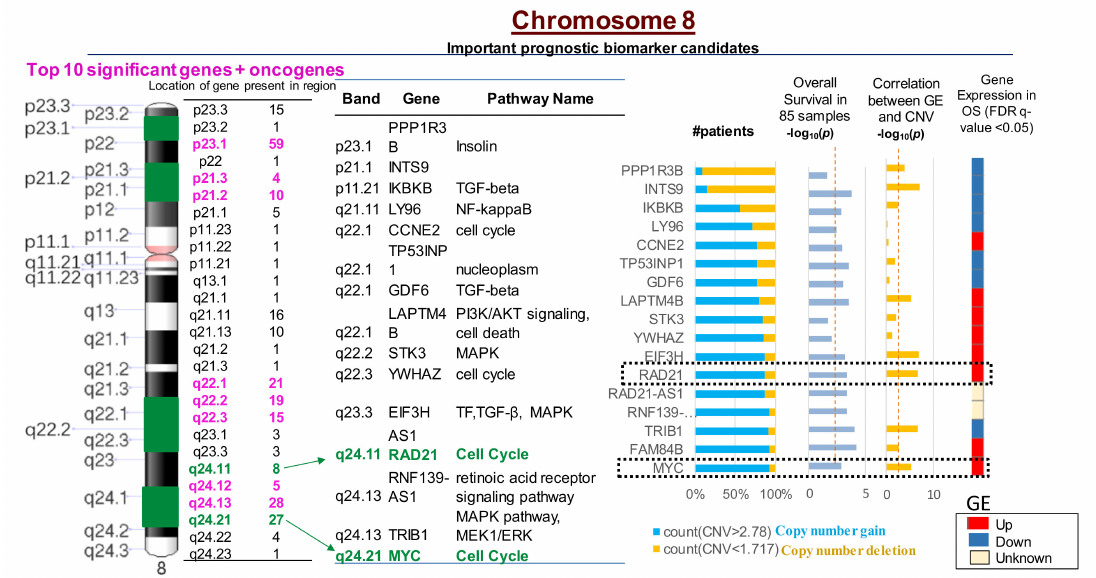
Figure 3. Most significant CNVs correlated with poor overall survival in OS patients are present on chromosome 8. There are 260 genes with CNVs present on chromosome 8 that are correlated with increased gene expression (GE) and poor survival in OS. The MYC-RAD21 + signature on chromosome 8q is among the top 10 most significant copy number gains correlated with poor OS survival in over 90% of patients ( p < 0.001) and increased GE ( p < 0.0001). CNV < 1.72 indicates deletions; CNV > 2.78 suggests copy number gains. The red dotted line in the columns (i.e., overall survival and correlation between GE and CNV -log 10 ( p ) values) indicates statistically significant di ff erences between the variables, p <